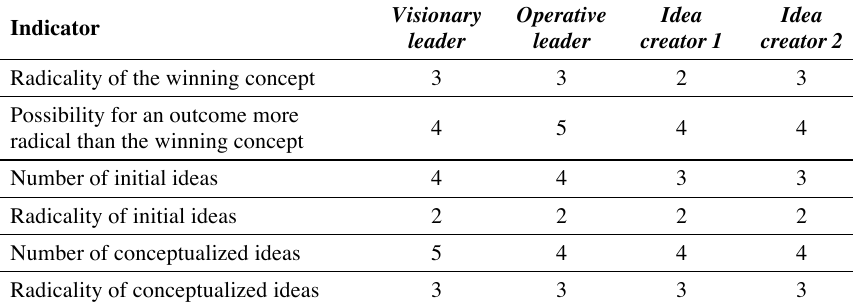
Table 1. Evaluations of the quality and quantity of the created ideas and concepts.